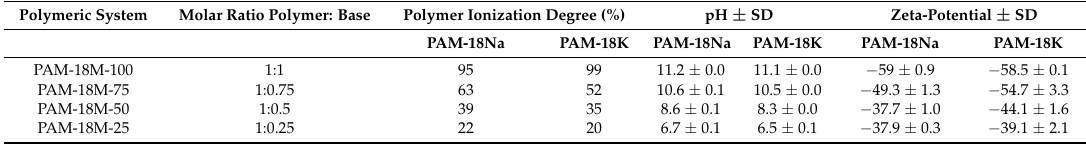
Table 1. Ionization degree obtained for polymeric materials derived from PAM-18. Polymeric System Molar Ratio Polymer: